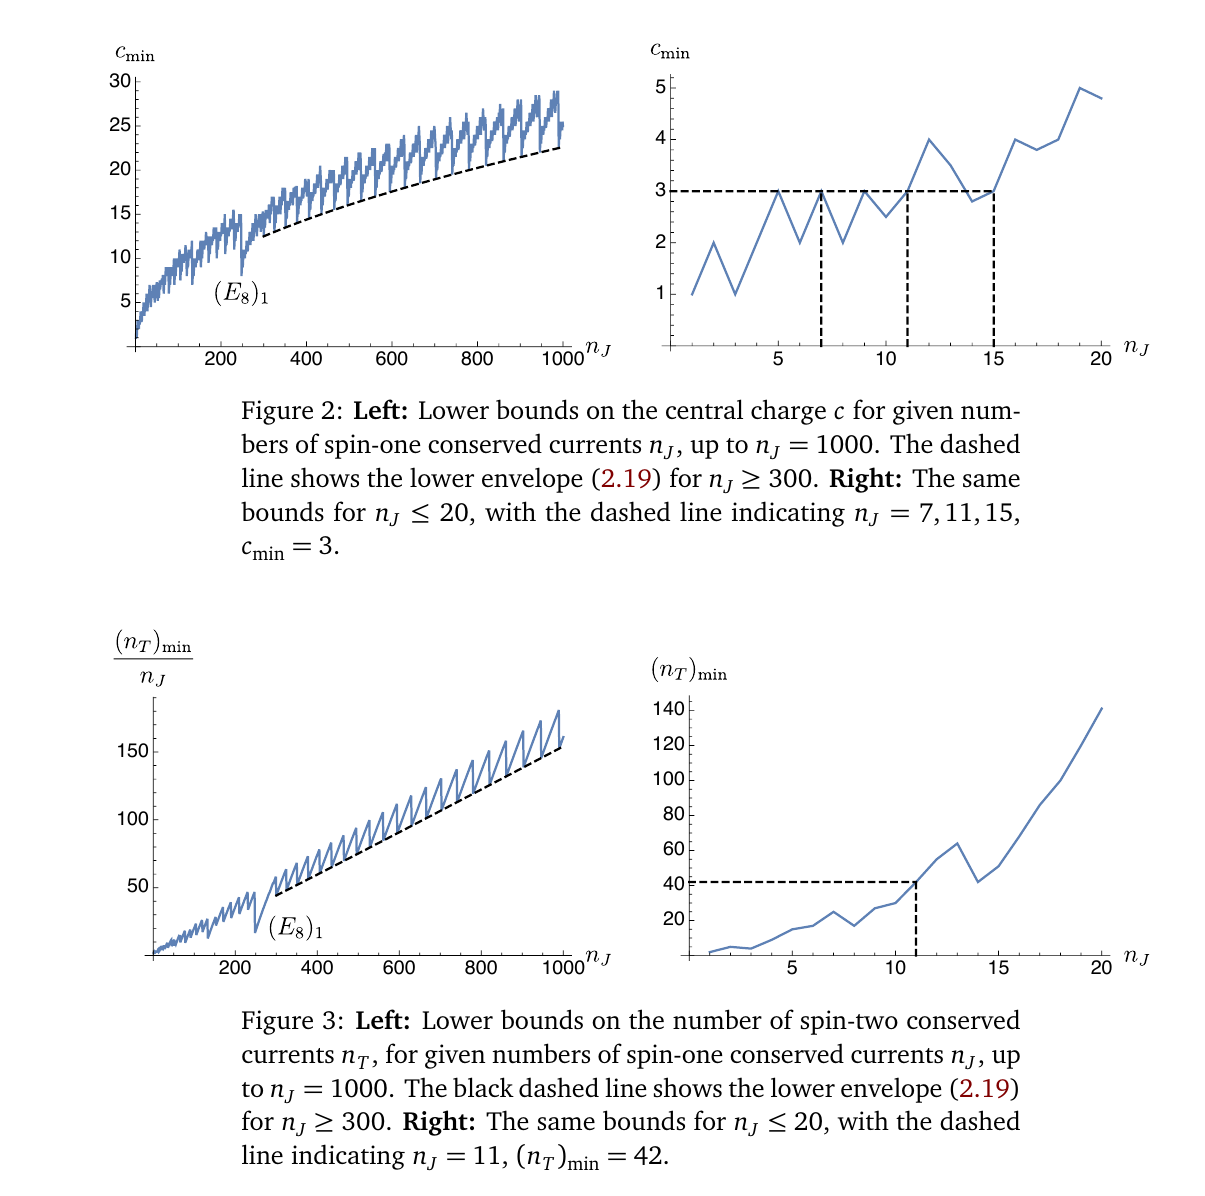
Figure 3: Left: Lower bounds on the number of spin-two conserved currents n , for given numbers of spin-one conserved currents n T = 1000. The black dashed line shows the lower envelope (2.19) to n J ≥ 300. Right: The same bounds for n ≤ 20, with the dashed for n J J = 11, ( n ) = line indicating n J T min